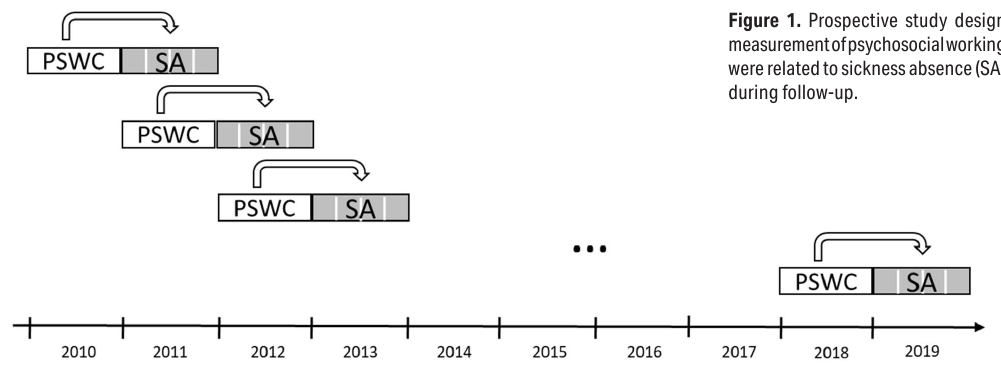
Figure 1. Prospective study design of how repeated measurement of psychosocial working conditions (PSWC) were related to sickness absence (SA) the following year during